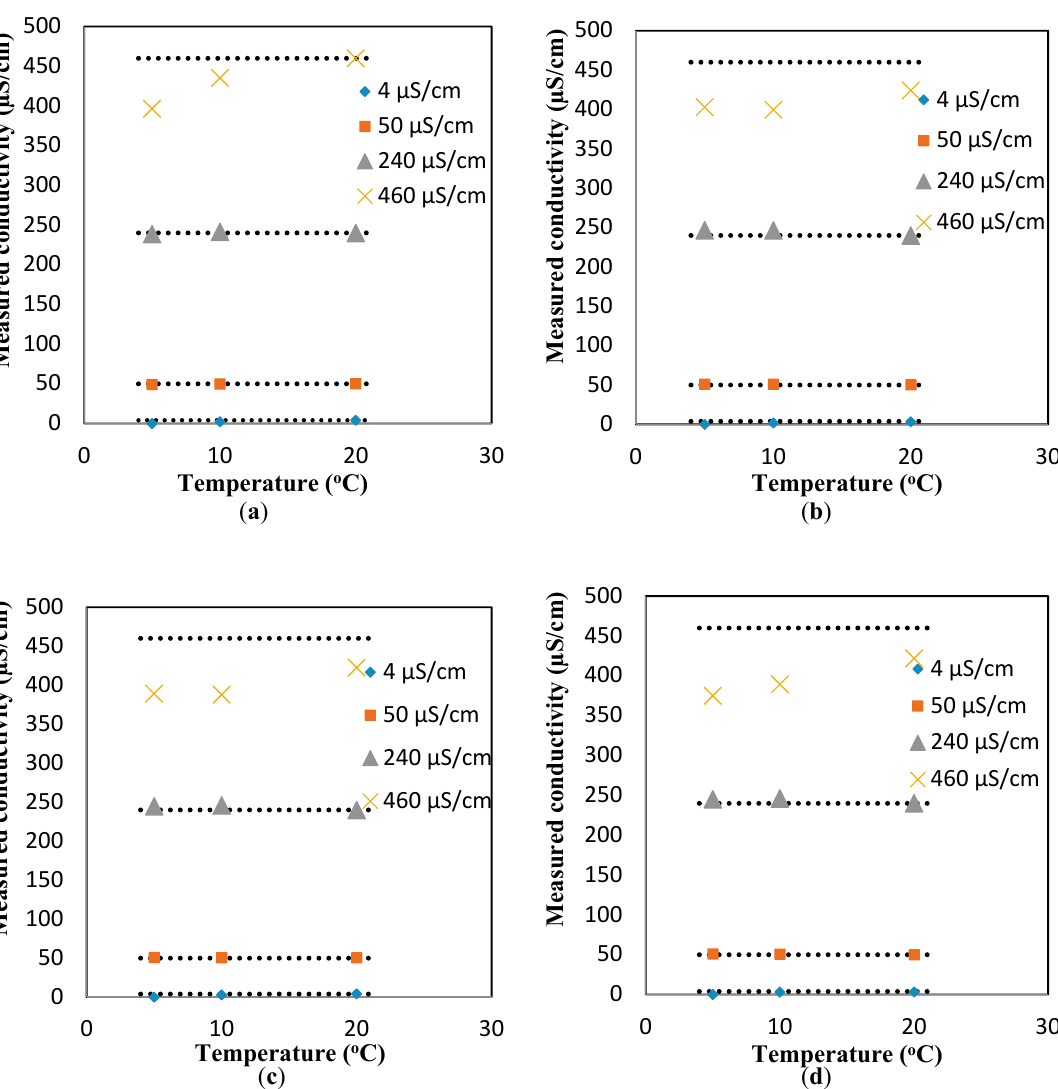
Figure 4. The measured conductivity after adding the compensation factor (a function of measured conductivity and temperature) for different conductivity solutions at flowrates of ( a ) 0 mL/min; ( b ) 10 mL/min; ( c ) 20 mL/min; and ( d ) 30 mL/min.